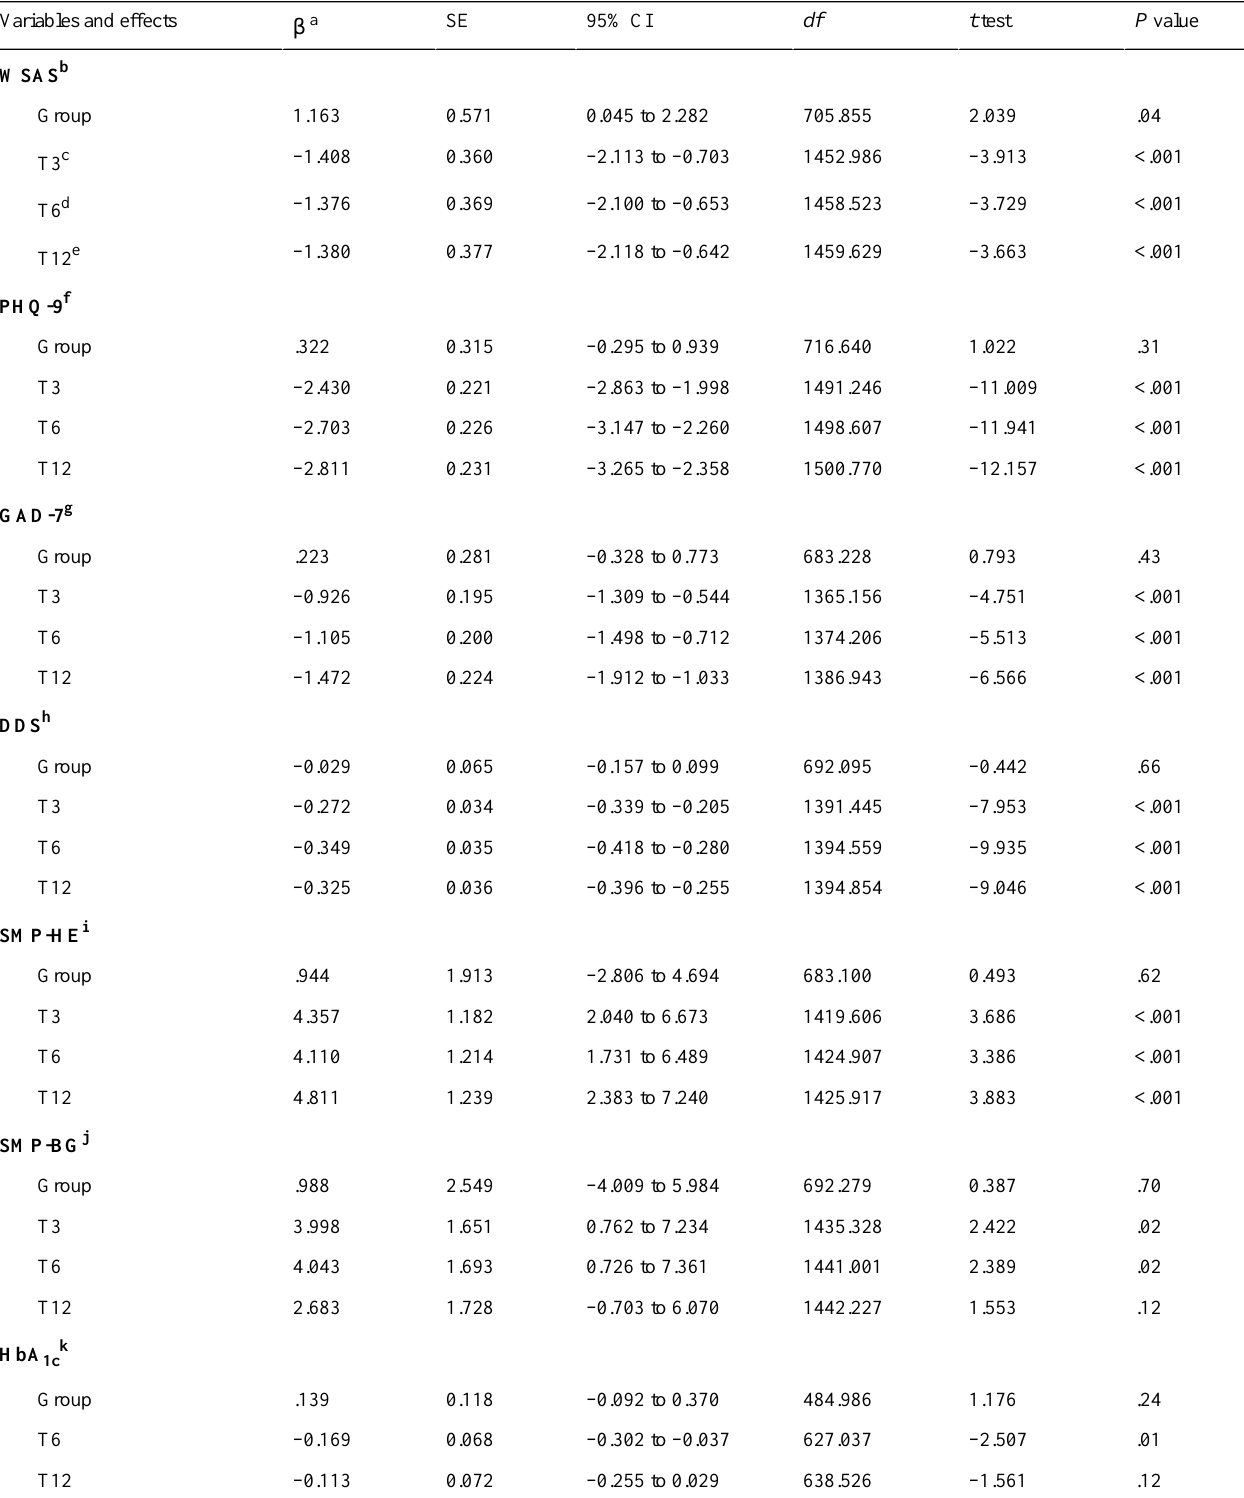
Table 4. Mixed model repeated measures fixed effects for time, group, and time×group on primary and secondary outcome